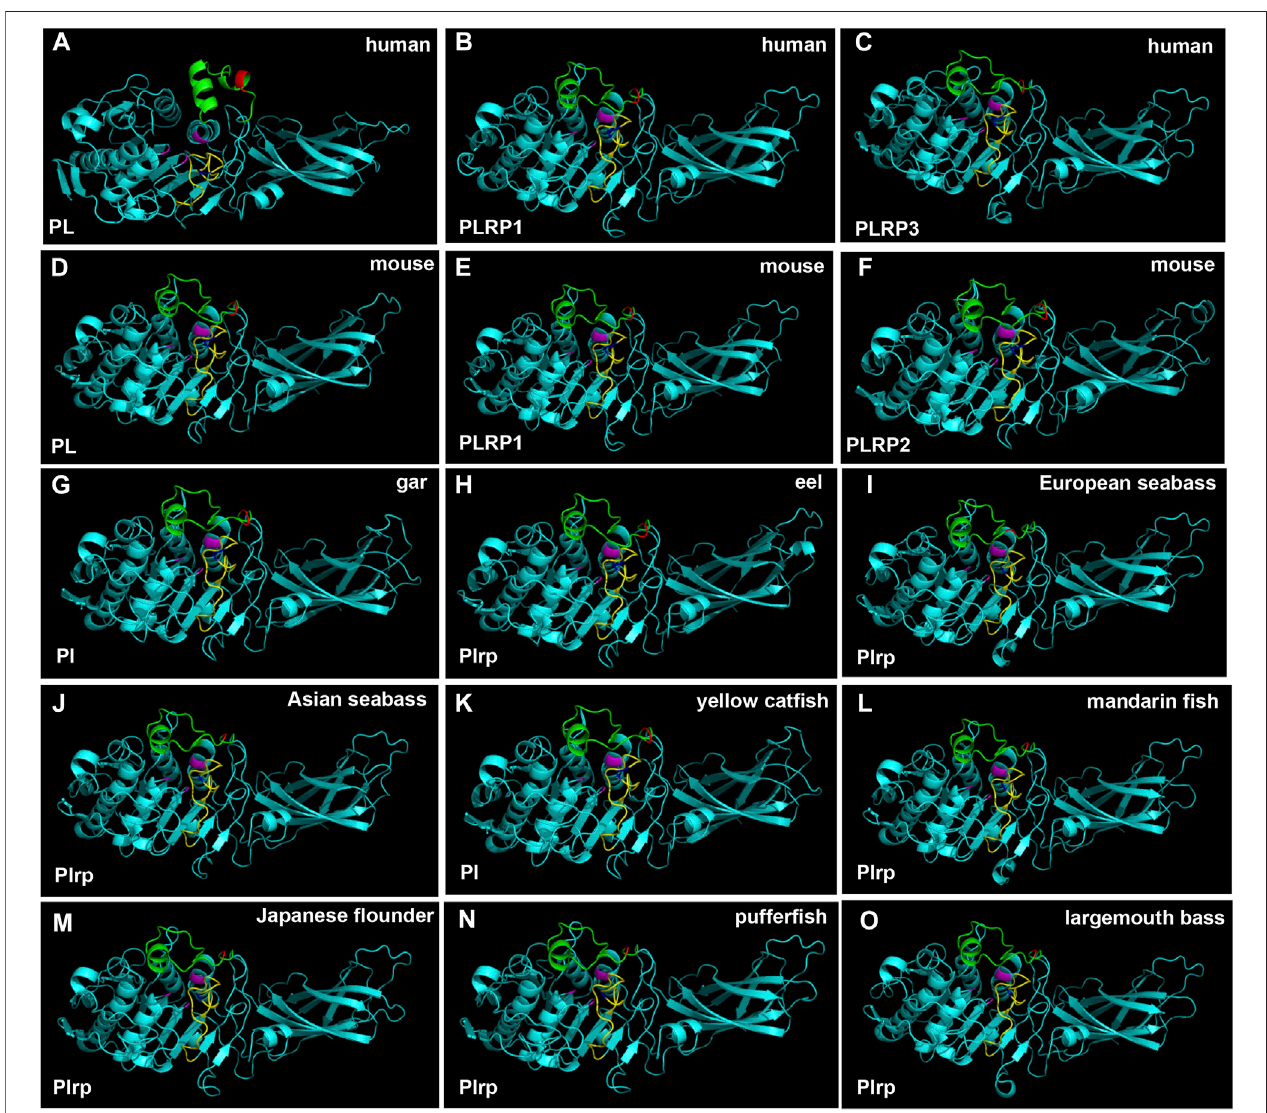
FIGURE 7| 3D structuresof pancreatic lipase in human, mouse, and partial fi sh species.The lid domain and β -9 loop of pancreatic lipase were marked with green and yellow, respectively. The regions ofIle and Leu (or replaced by other amino acids) in the lid domain and β -9 loop were marked with red and blue, respectively.Active site triad residues Ser, Asp, and His were marked with